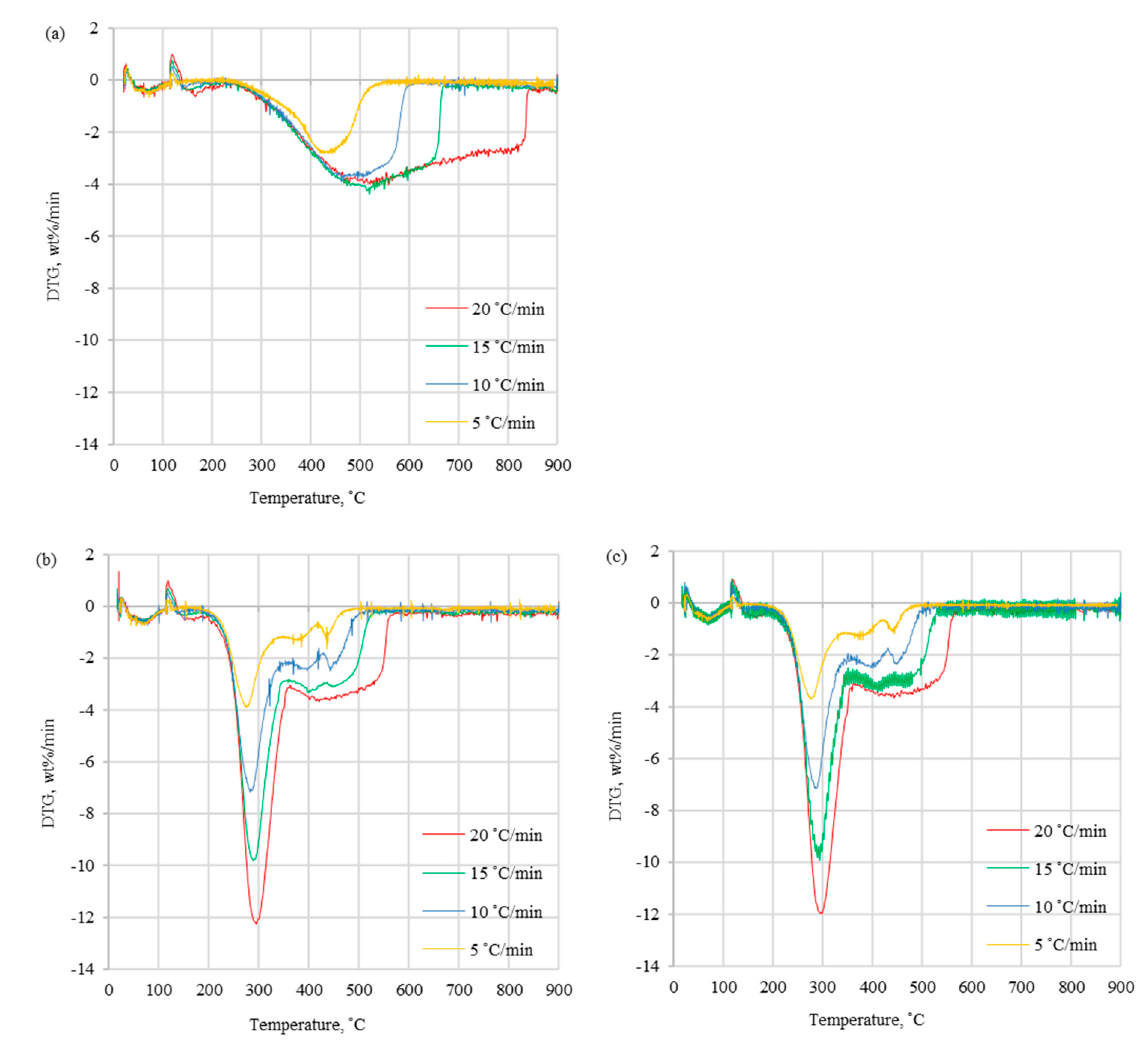
Figure 5. DTG curves for ( a ) WS, ( b ) DS0, and ( c ) DS4 at different heating rates.